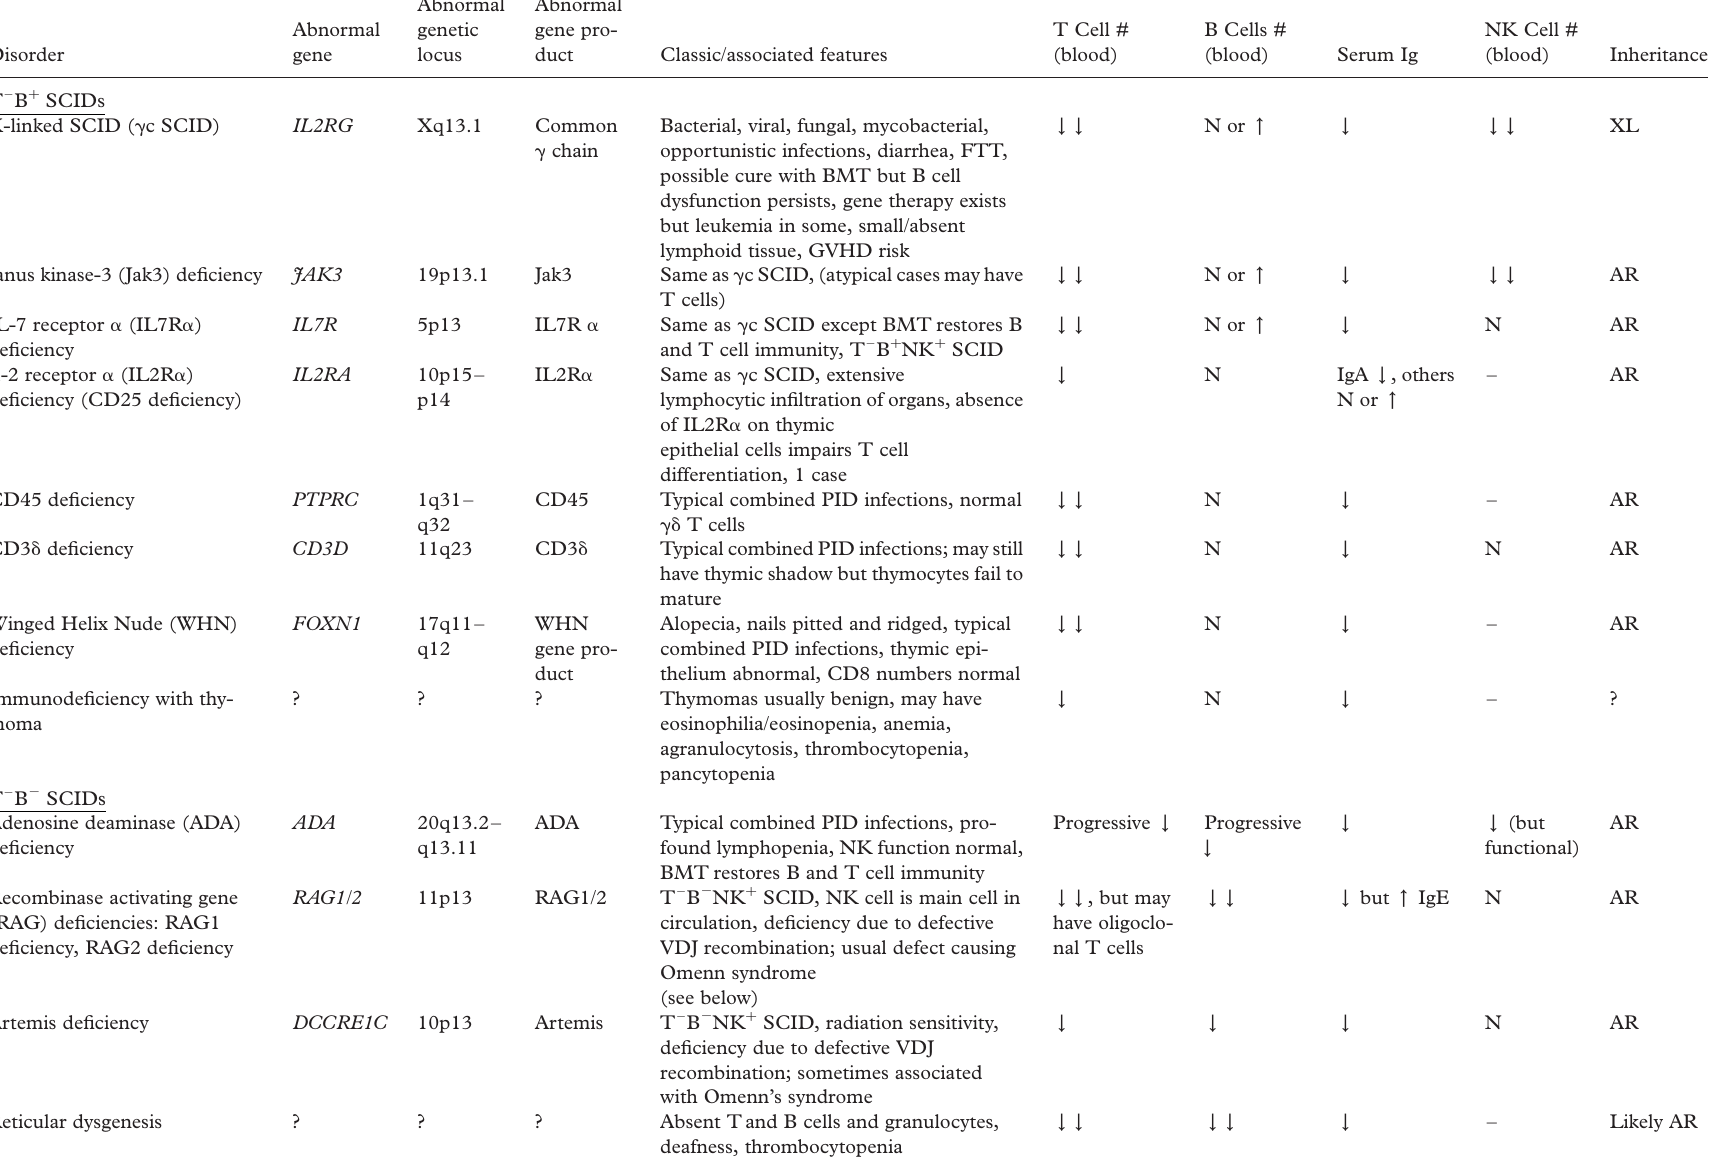
Table III. Combined